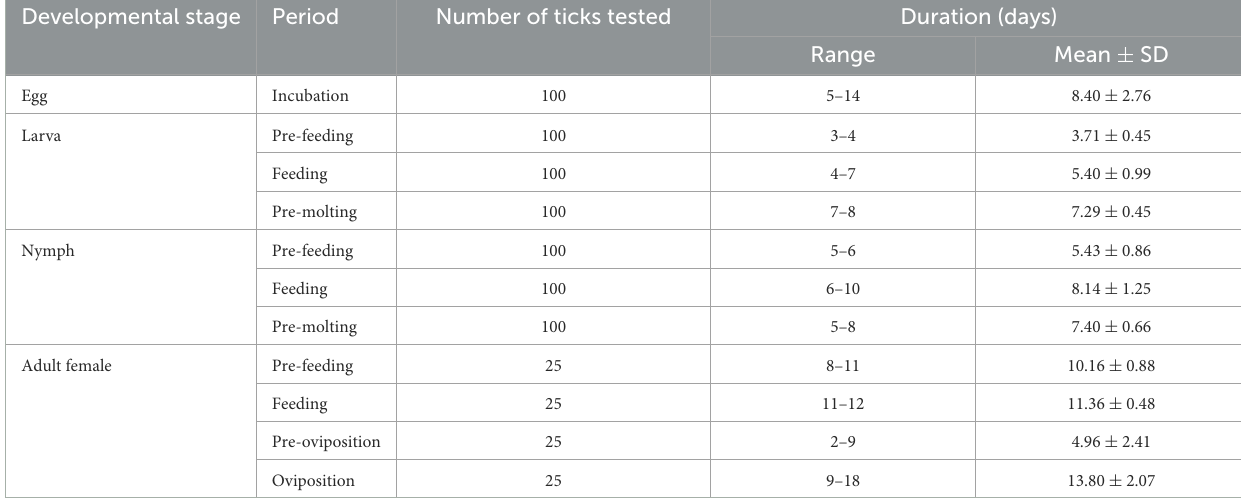
TABLE 3 The durations of various developmental stages of D. nuttalli .